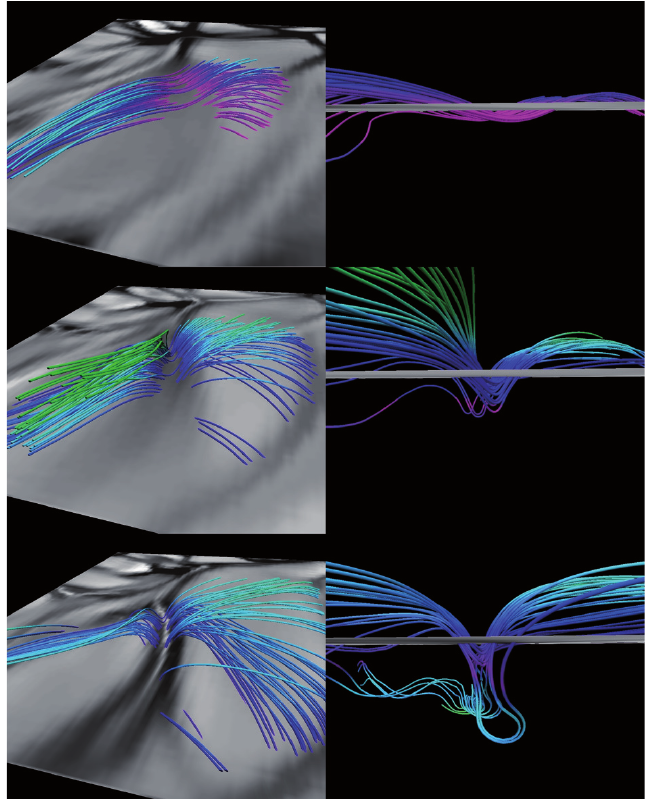
Figure 28: 3D visualization of the interaction of emerging horizontal magnetic field with granular con- vection (from Tortosa-Andreu and Moreno-Insertis, 2009). The grey scale maps show the distribution of vertical velocity at constant geometrical height in the photosphere. This sequence of magnetic field line visualizations shows how the convective flows undulate emerging field lines at the scale of granulation and leads to the formation of submerging U-loops aligned with downflows. Image reproduced with permission, copyright by